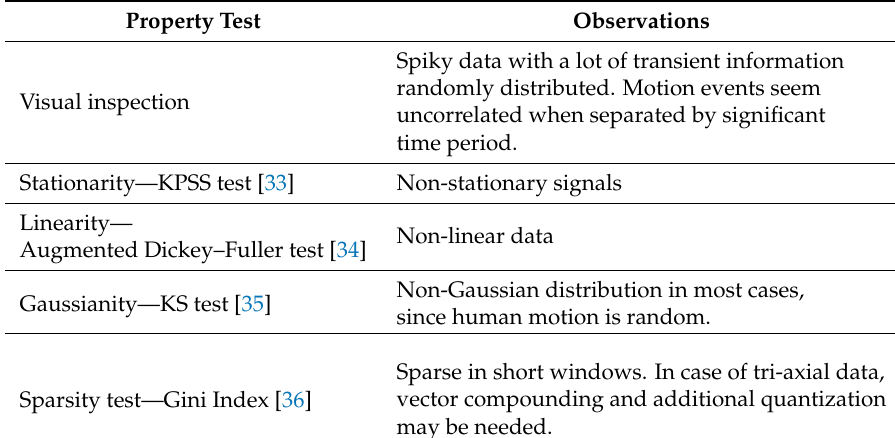
Table 1. Actigraphy signal